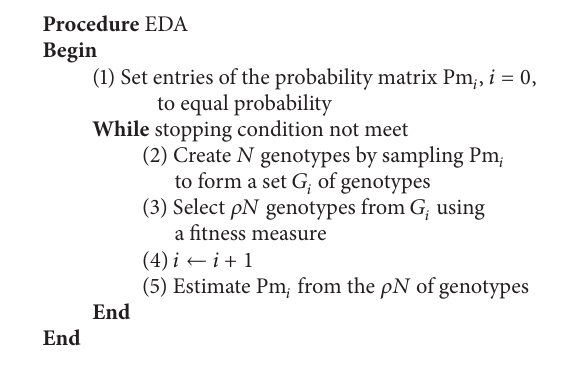
Algorithm 2: Estimation of Distribution Algorithm.